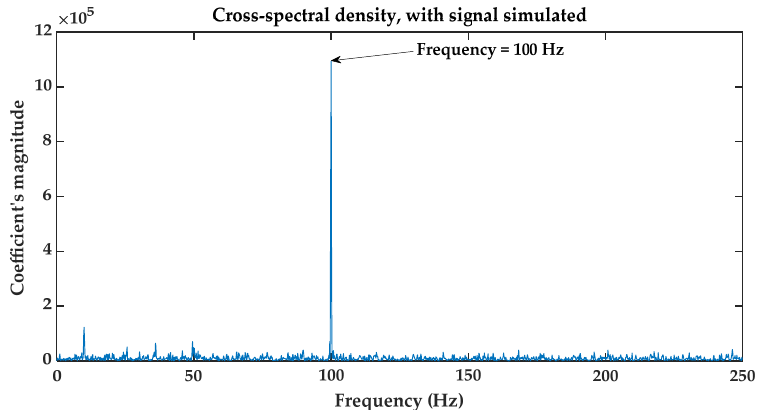
Figure 2. Cross-spectral density, with two synthetic signals: S 1 = sin ( 2 π 10 t ) + sin ( 2 π 100 t ) and S 1 = sin ( 2 π 50 t ) + sin ( 2 π 100 t ) .